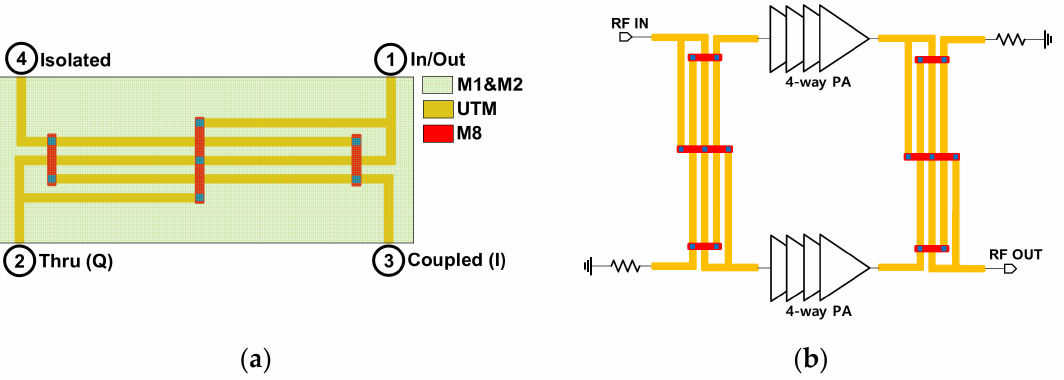
Figure 8. ( a ) Structure of the microstrip Lange coupler and ( b ) block diagram of the balanced PA with the Lange